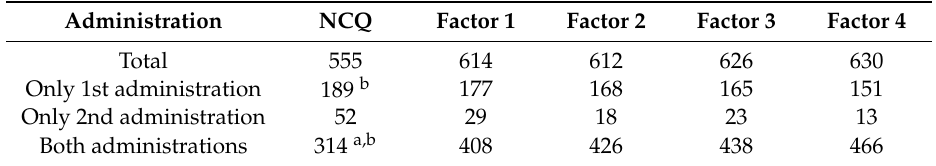
Table 3. Sample sizes for each score type provided from the All Available sample ( N =